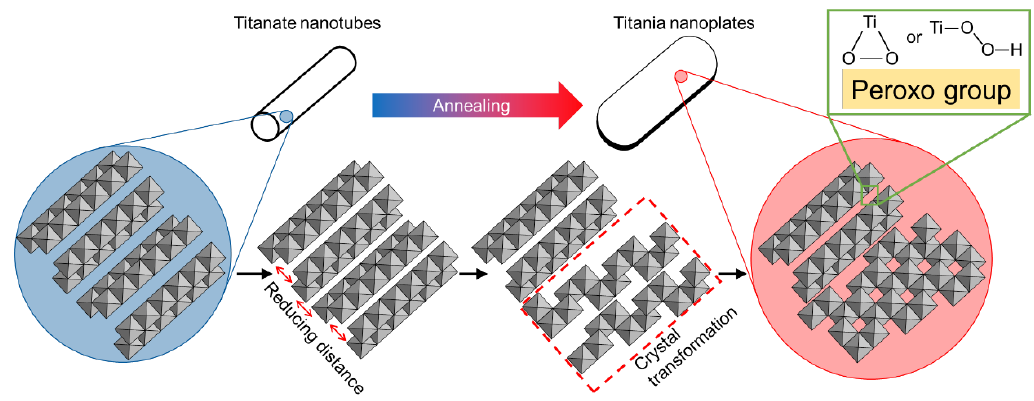
Figure 10. Hypothetical scheme for the transformation of titanate nanotubes to titania nanoplates. The structure models presented are the projections along the nanotube. The transformed structure shown is the anatase phase.